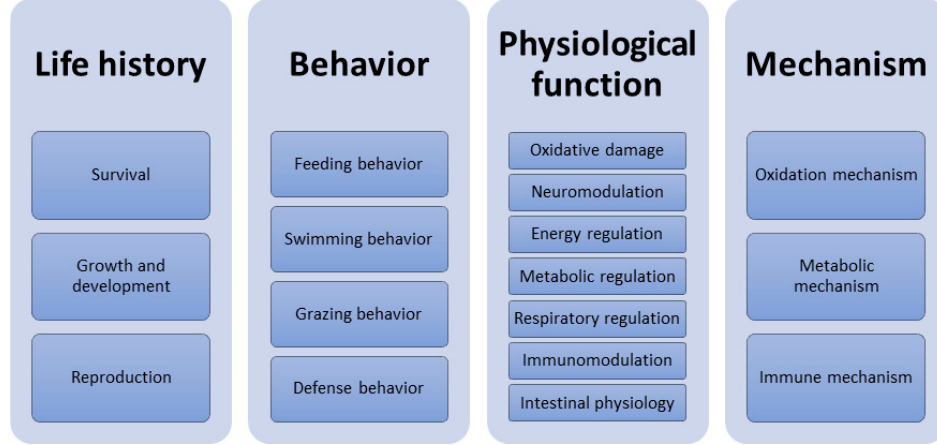
Figure 1. Effects of microplastics on aquatic